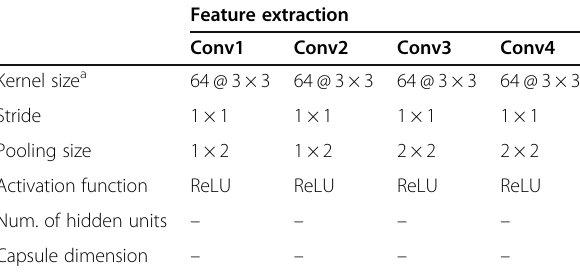
Table 2 Model parameters (feature extraction) Feature